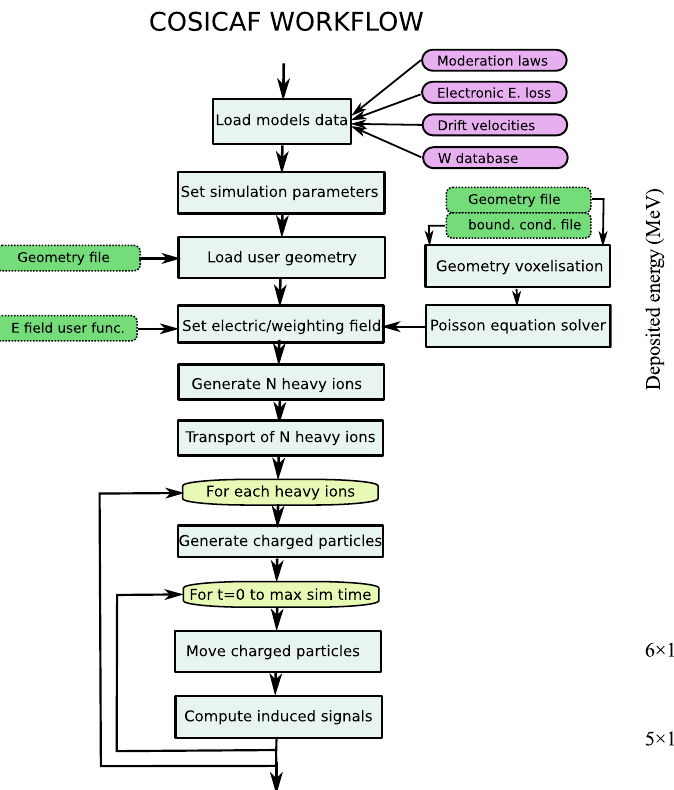
Fig. 10. Summary of COSICAF operation.